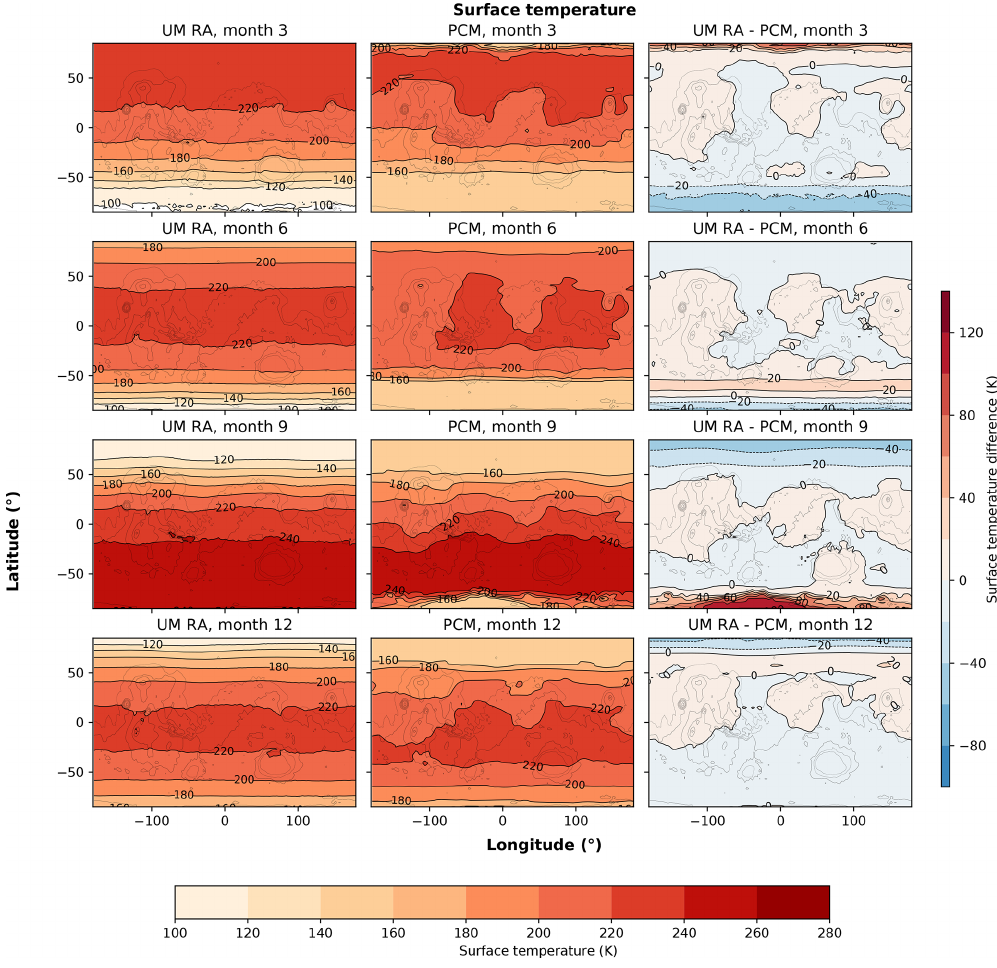
Figure 12. Surface temperature (K) across four seasons within the Martian year; each month is the average taken of all sols within that month (months according to Table A1). The RA dust scenario is shown on the left, the PCM output is in the centre and the differences between the RA and PCM outputs are on the right. Colour scales in the left-hand and centre plots are matched across all months and between models with contour intervals of 20K. The colour scales in the difference plots are also matched across all months and contour intervals are also